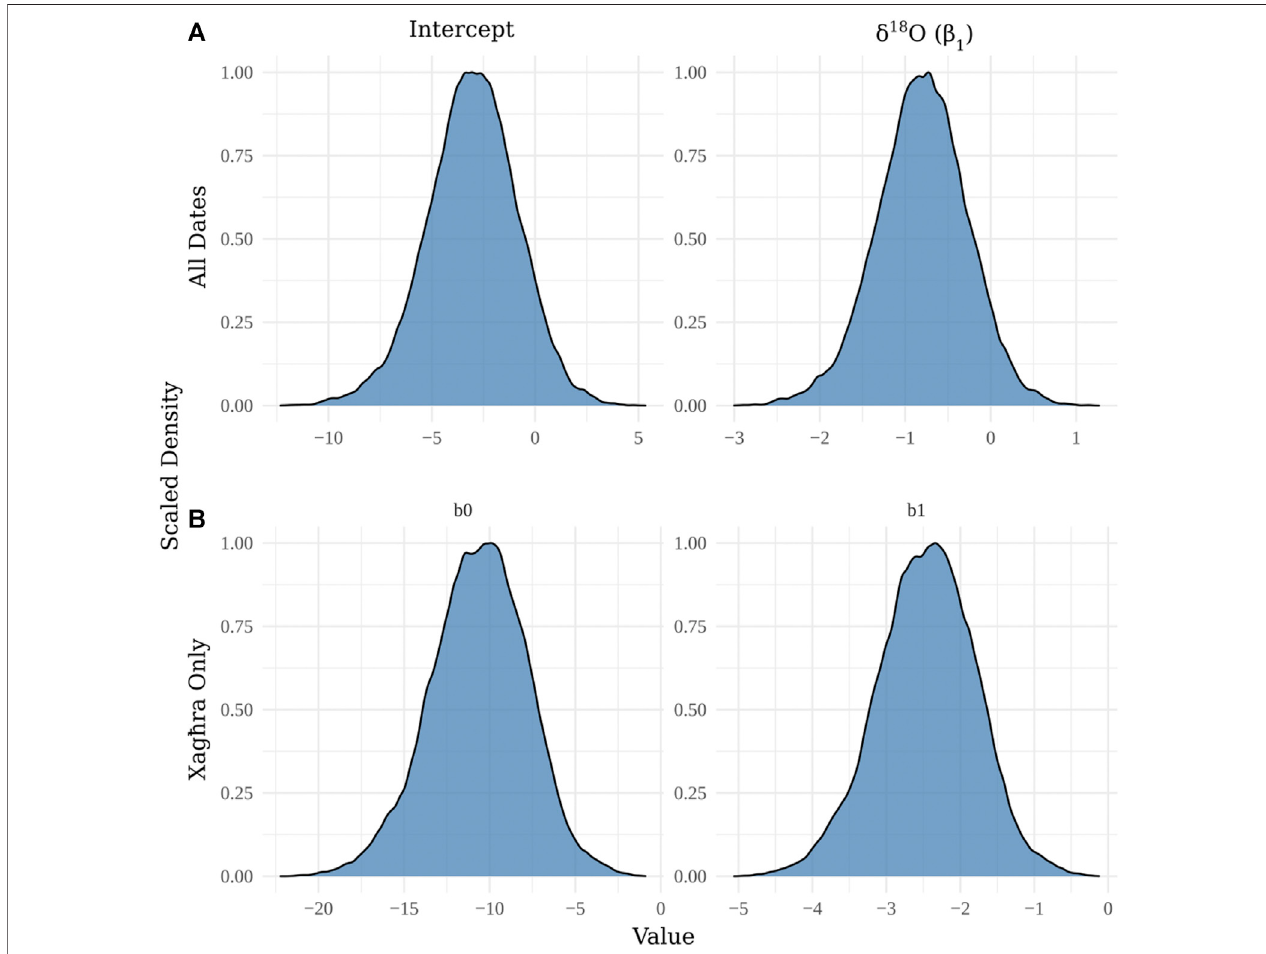
FIGURE 11 | Regression results for the REC models for all Maltese radiocarbon dates and climate (A) , and for only the Xag ħ ra circle (B) . The left columns indicate themodelintercept(i.e.,themeaneventcounts,holdingthe δ 18 Ocovariatesconstantattheirstudy-periodmeans)thecolumnsontherightindicatetheeffectsofclimate (variation in δ 18 O) on the frequency of radiocarbon dated samples. The negative values indicate that drier conditions correlate with reduced numbers of radiocarbon dates.